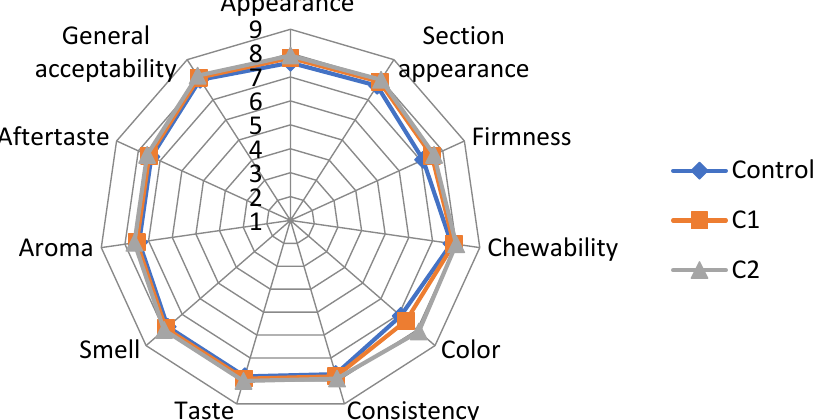
Figure 7. Comparative diagram of the sensory attributes specific to crackers: Control = crackers without powder addition; C1 and C2 = crackers with, respectively, 1 and 3% powder of red OS ex- tract.